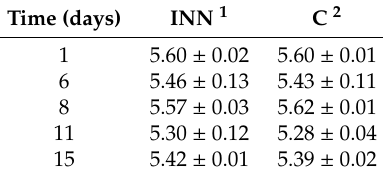
Table 1. pH evolution in innovative and traditional Squacquerone cheeses during refrigerated storage.